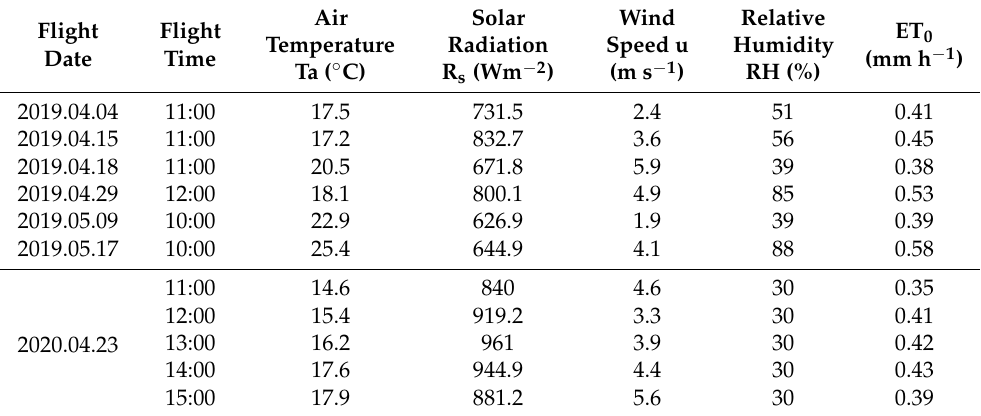
Table 2. Flight dates, time, and main environmental parameters at the time of the flight that were